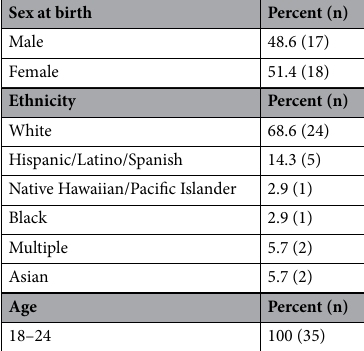
Table 1. Demographic data of the study